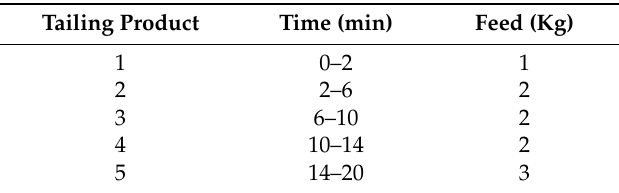
Table 2. Tailings collection times for Knelson concentrator trial, based on movement of feed through the concentrator.